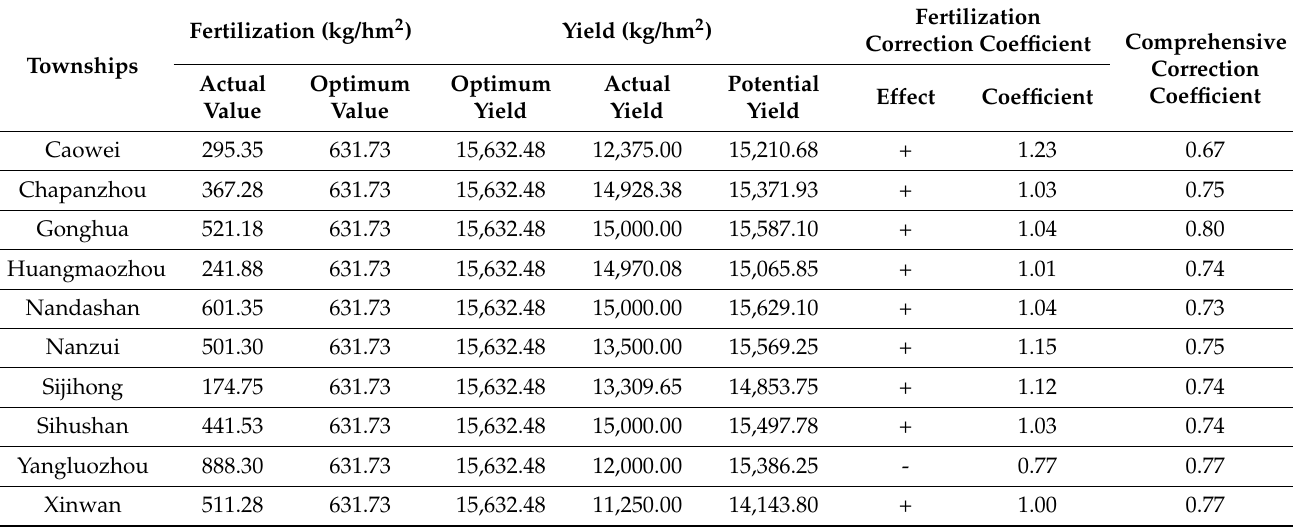
Table 2. Correction coefficient of management and input level in towns.